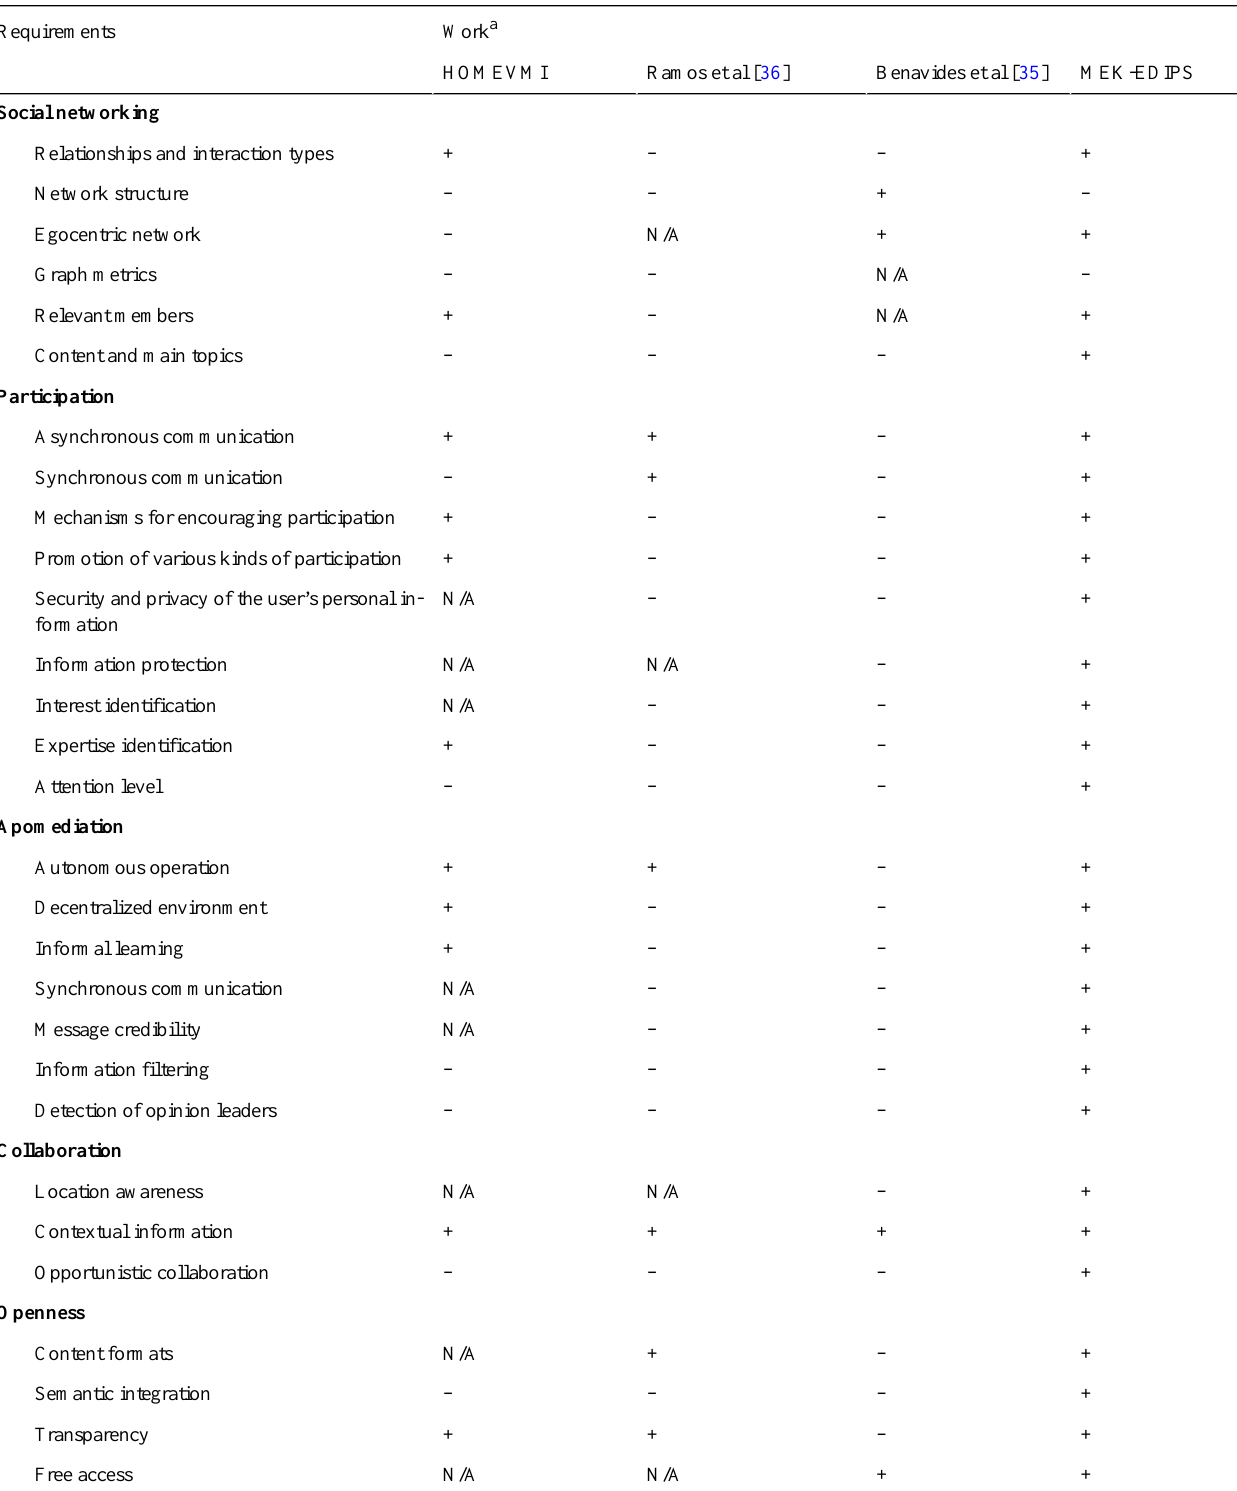
Table 2. Proposed works: Analysis from Medicine 2.0